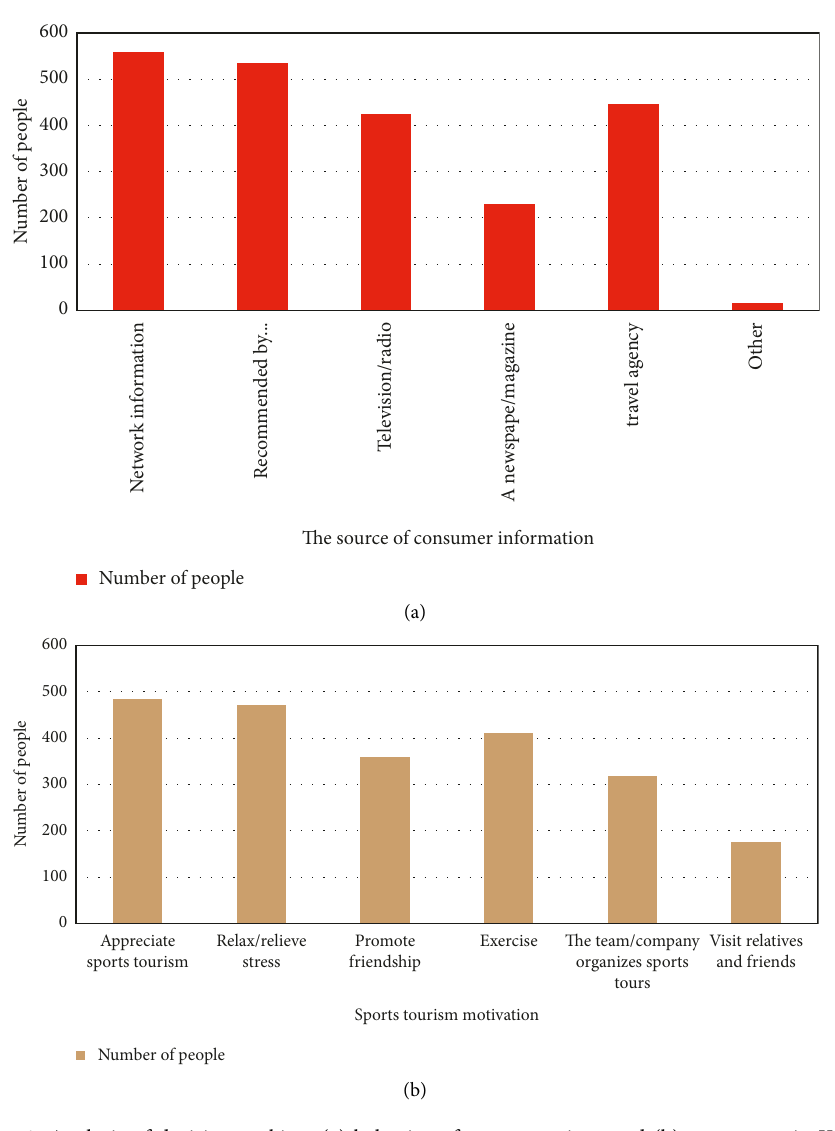
Figure 9: Analysis of decision-making, (a) behavior of sports tourism, and (b) consumers in X city. Table 4: Statistical analysis table of sports tourism consumers’ Table 5: Statistical analysis of the main consumption structure of travel season preference. sports tourism